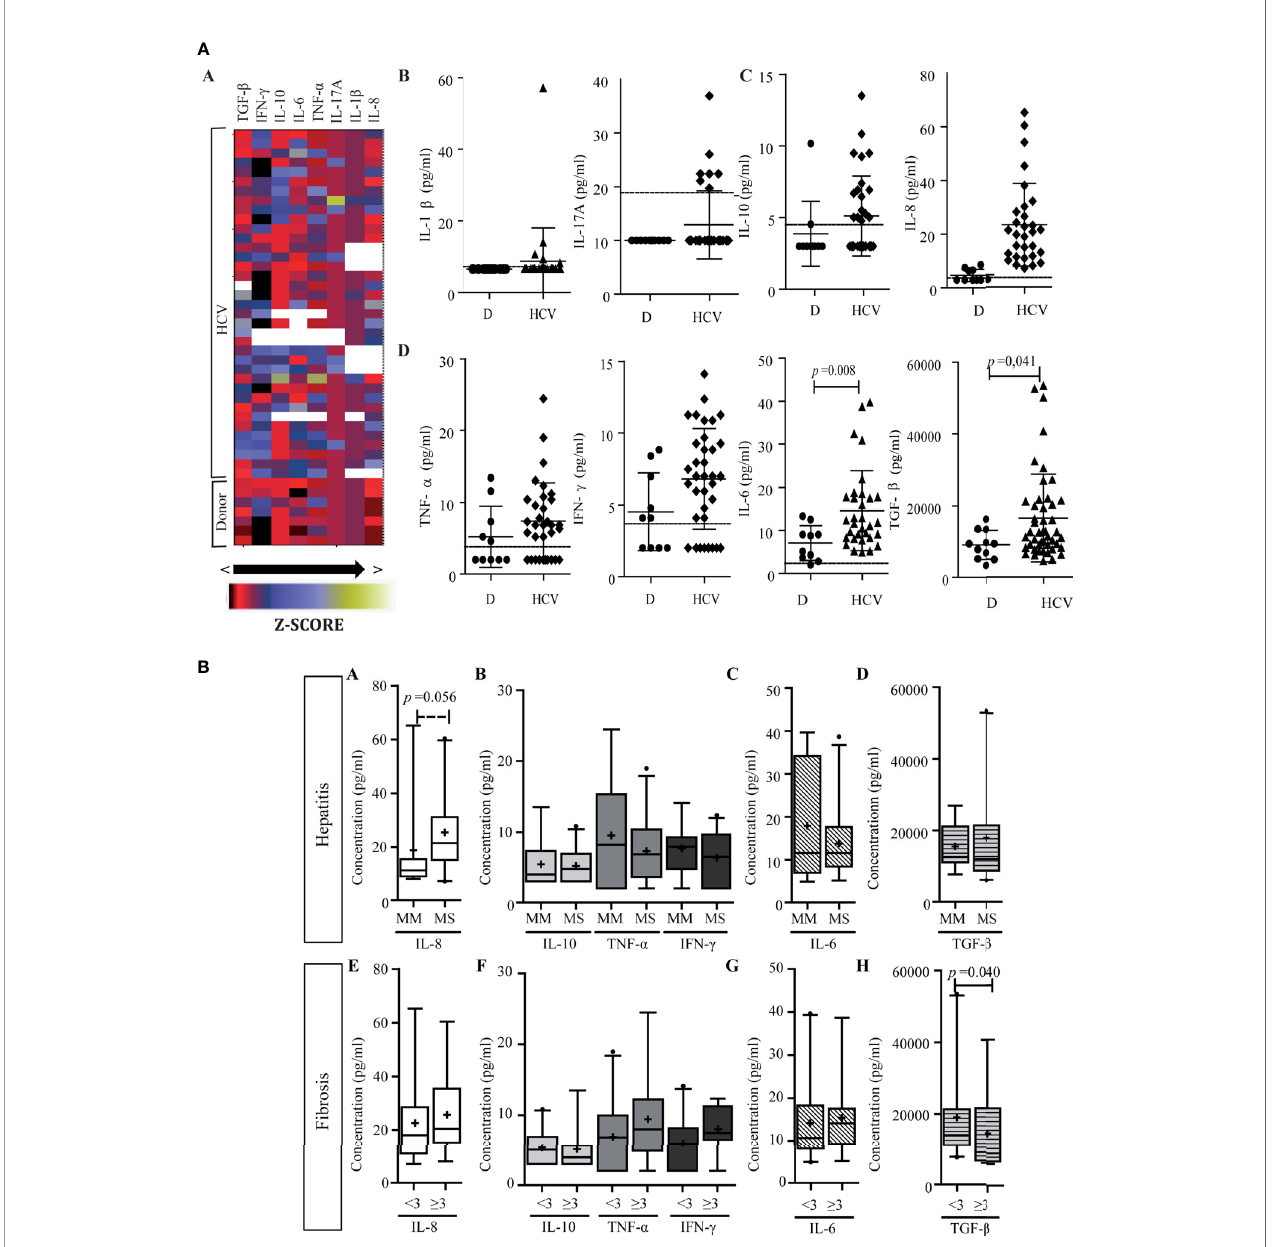
FIGURE 7 | Peripheral cytokine level. (A) Heat map of peripheral cytokine expression levels (a) and comparison of circulating cytokine levels between patients and donors (b – d). (a) Each row corresponds to the cytokine indicated at the top, and each column represents one case. The data are normalized, and the results are expressed as a Z-score (Xi-/SD), which is assigned a color scale from black (lowest values) to yellow (highest values). The white boxes correspond to the cases without data. (b – d) Cytokine levels in patients and donors: IL-1 b and IL-17A (b), IL-10 and IL-8 (c), and TNF- a , IFN- g , IL-6, and TGF- b (d). D donor. Results are plotted on dot diagrams, the middle horizontal line indicates the mean, and the outer horizontal lines represent the SD. Mann – Whitney U test was used to compare data sets. (B) Relationship between circulating cytokine levels and liver damage. Circulating levels of cytokines in relation to hepatitis (a – d) and fi brosis (e – h) severity. MM, minimal – mild; MS, moderate – severe hepatitis. Advanced fi brosis (F ≥ 3) according to METAVIR. The results are depicted in box plots. Horizontal lines within boxes indicate medians. Horizontal lines outside the boxes represent the 5 and 95 percentiles. Mean is indicated as +. Mann – Whitney U test was used to compare data